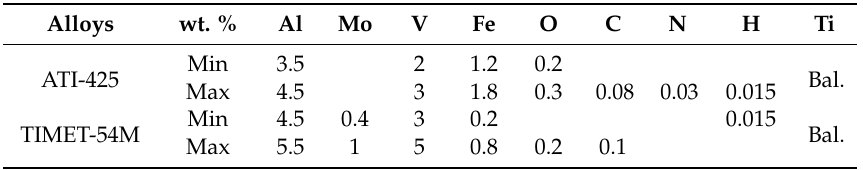
Table 1. Mass fraction (wt. %) composition of the